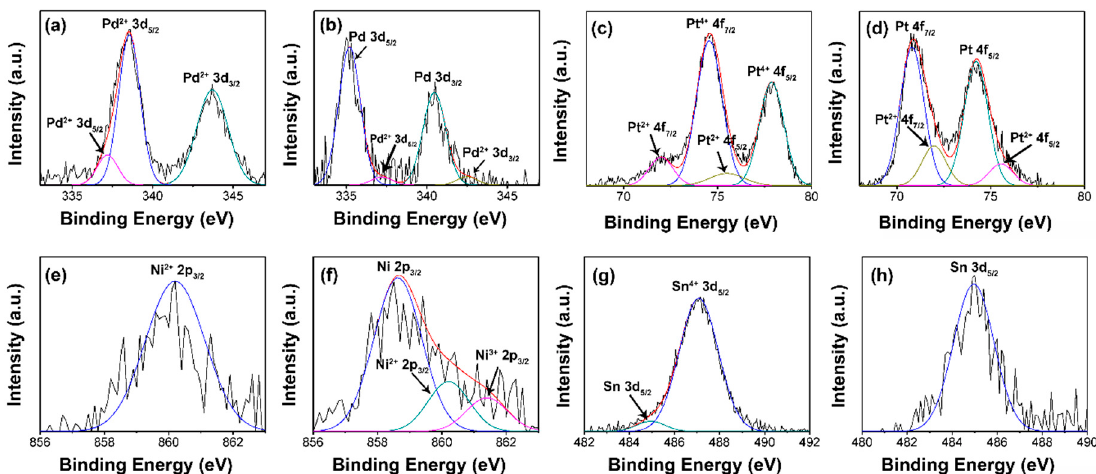
Figure 7. Deconvoluted XPS spectra of the loaded metal in the aerogels. Pd in Pd loaded aerogels ( a ) as prepared and ( b ) after reduction, Pt in Pt loaded aerogels ( c ) as prepared and ( d ) after reduction, Ni in Ni loaded aerogels ( e ) as prepared and ( f ) after reduction, Sn in Sn loaded aerogels ( g ) as prepared and ( h ) after reduction are shown.